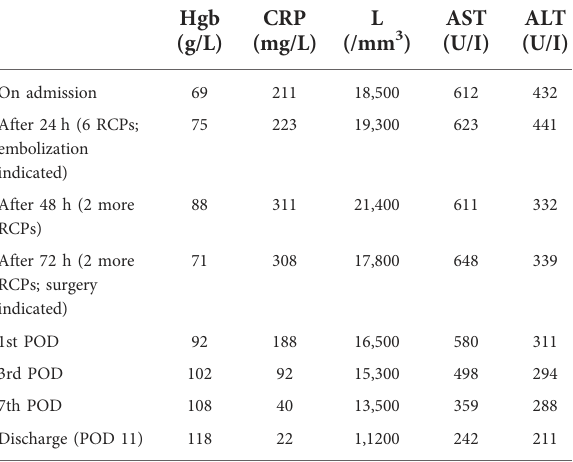
TABLE 1 Laboratory results over the treatment